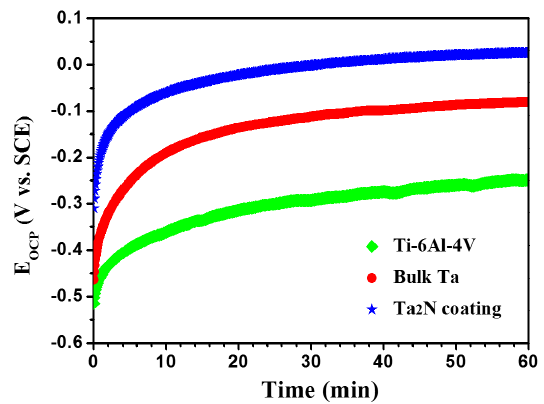
Figure 7. Variation of open circuit potential with time for uncoated Ti-6Al-4V, commercially pure Ta and the Ta 2 N coating in Ringer’s physiological solution at 37 °C.